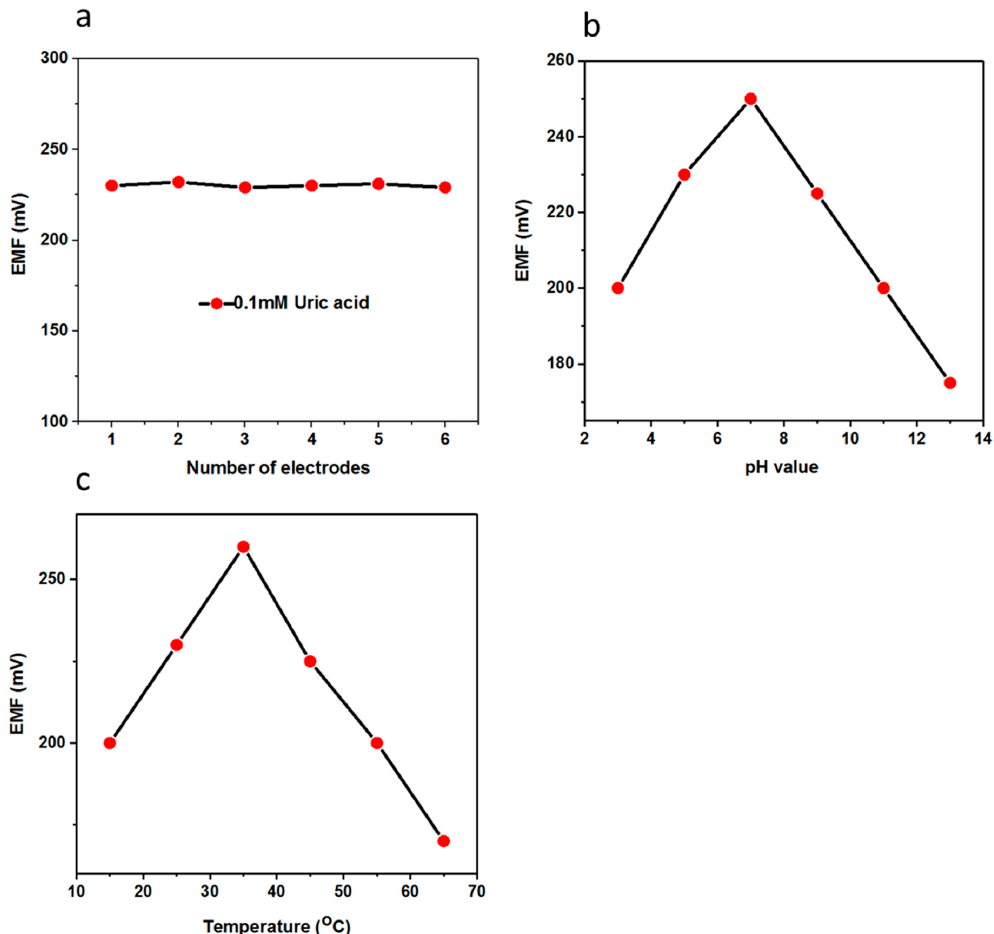
Figure 5. ( a ) The inter-electrode reproducibility of the uric acid biosensor in 0.1 mM uric acid; ( b ) the effect of pH on the output potential of the uric acid biosensor in 0.5 mM uric acid; ( c ) the effect of temperature on the potentiometric response of the uric acid biosensor in 0.5 mM uric acid. Table 1. The storage stability proposed uric acid biosensor based on CuO nanostructures. No of Weeks Linear Range Uric Acid